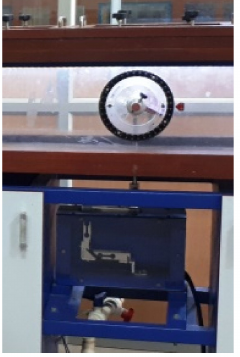
Figure 6. Test airfoil mounted to the three-component force balance